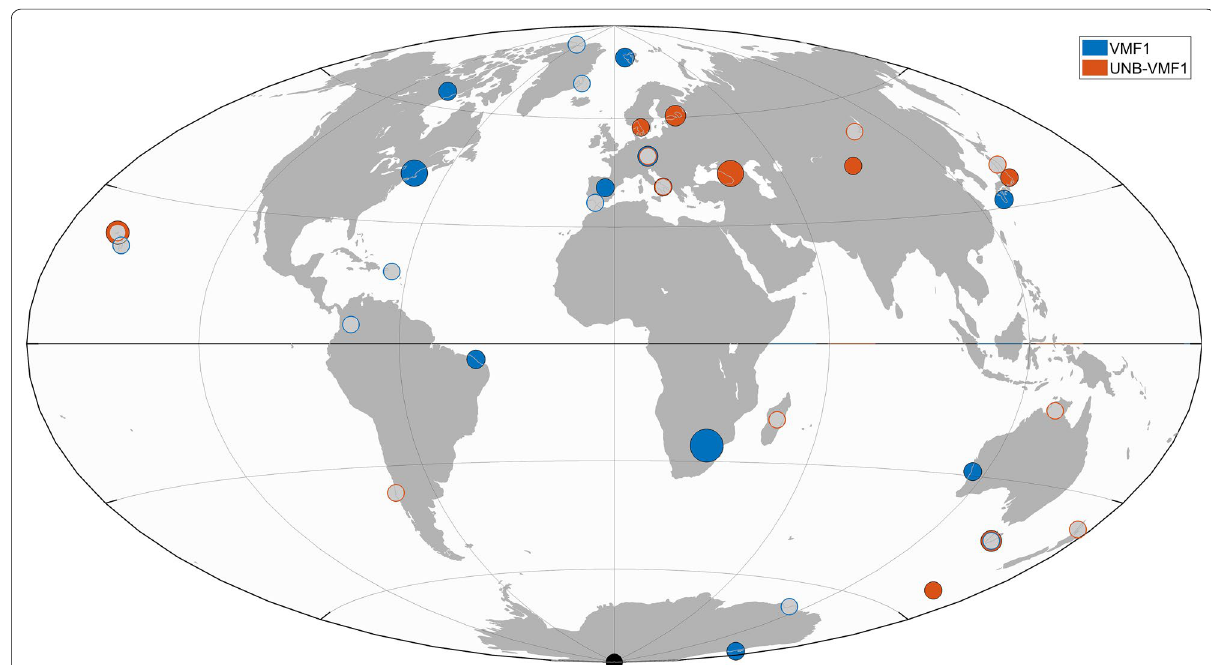
Fig. 13 Perspective view of the VLBI and GPS PDA stations’ height component wrms (mm) results; the color indicates the mapping function which reduced the latter. For the sites the respective difference was less than 1%, the color is gray. The nominal value is indicated by the black-colored